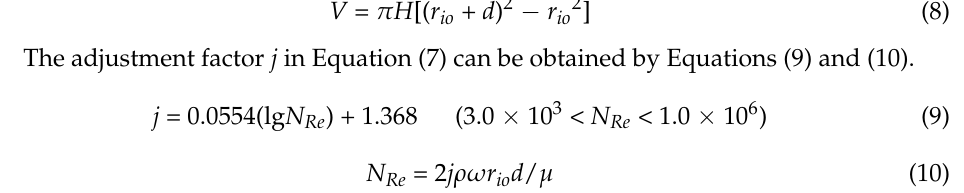
Figure 5. Variation in liquid holdup under different ( a ) annular widths with rotor inlet diameter of 6.0 mm; ( b ) clearance heights with annular width of 3.0 mm; ( c ) rotor inlet diameters with clearance height of 5.0 mm.